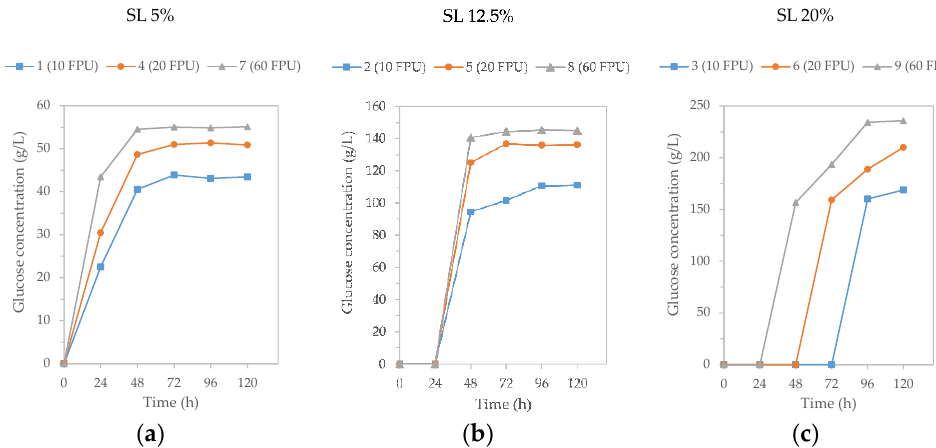
Figure 3. Glucose concentration (g/L) during enzymatic saccharification of CSopt using different cellulase loadings (10, 20, and 60 FPU/g cellulose) at low solid loading (SL of 5% w / w , ( a )), medium solid loading (SL of 12.5% w / w , ( b )), and high solid loading (SL of 20% w / w , ( c )).